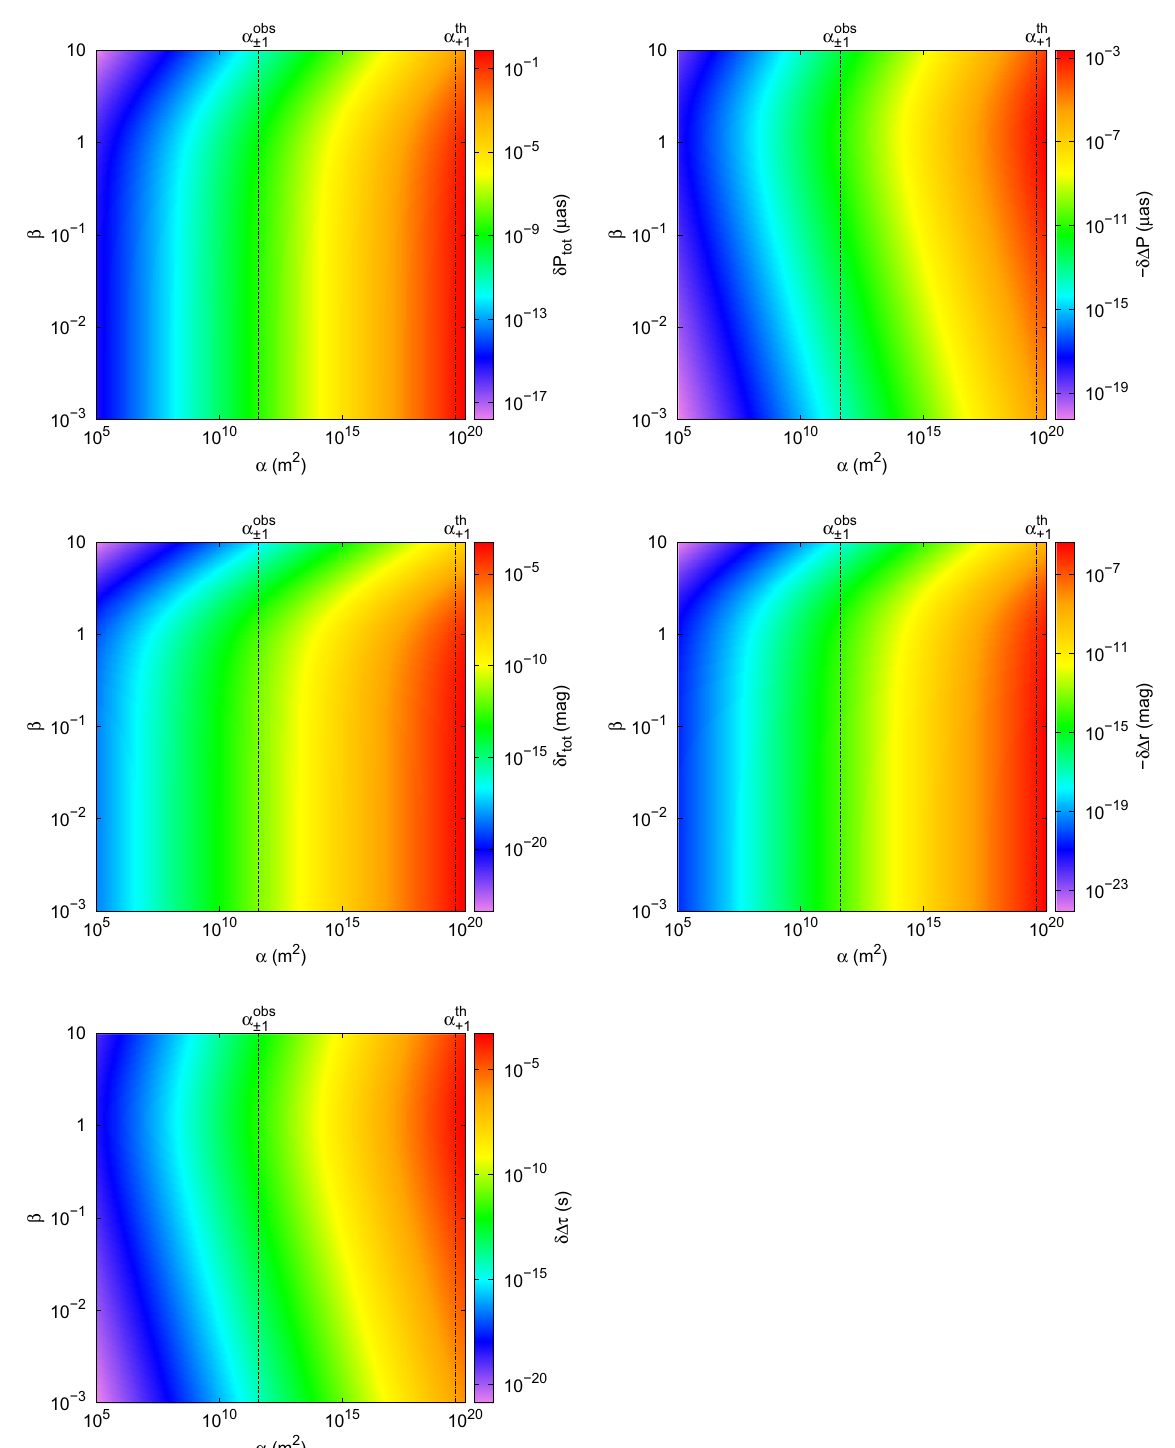
δΔ r δΔτ against α and β are respectively presented in logarith- tot and mic scales. In each sub-figure, the dashed line denotes the observational bound on α and the dash-dot one shows the theoretical bound. Here, the polarization s = 1 is taken; the contributions of s = − 1 can be sufficiently approximated by changing the signs of the ones shown in each